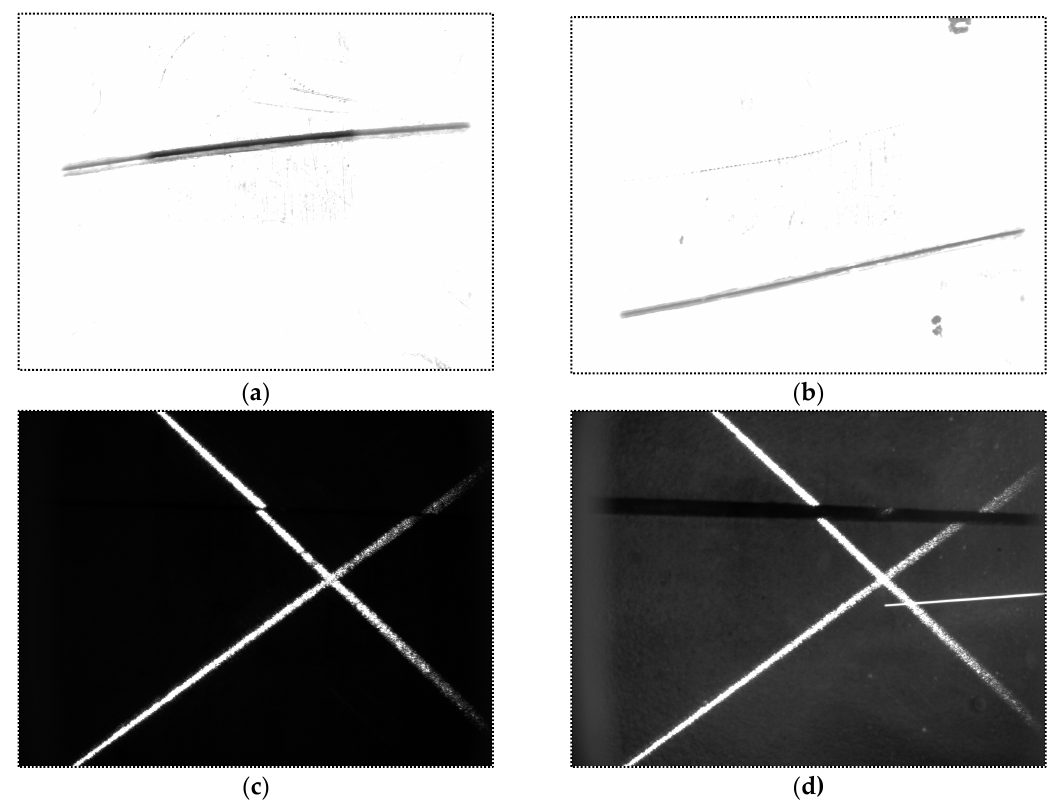
Figure 29. Images captured before and during welding. ( a ) The narrow butt image when the USLS is on before welding; ( b ) The narrow butt image when the USLS is on during welding; ( c ) The laser stripe image when the LLS is on before welding; ( d ) The laser stripe image when the LLS is on during welding.